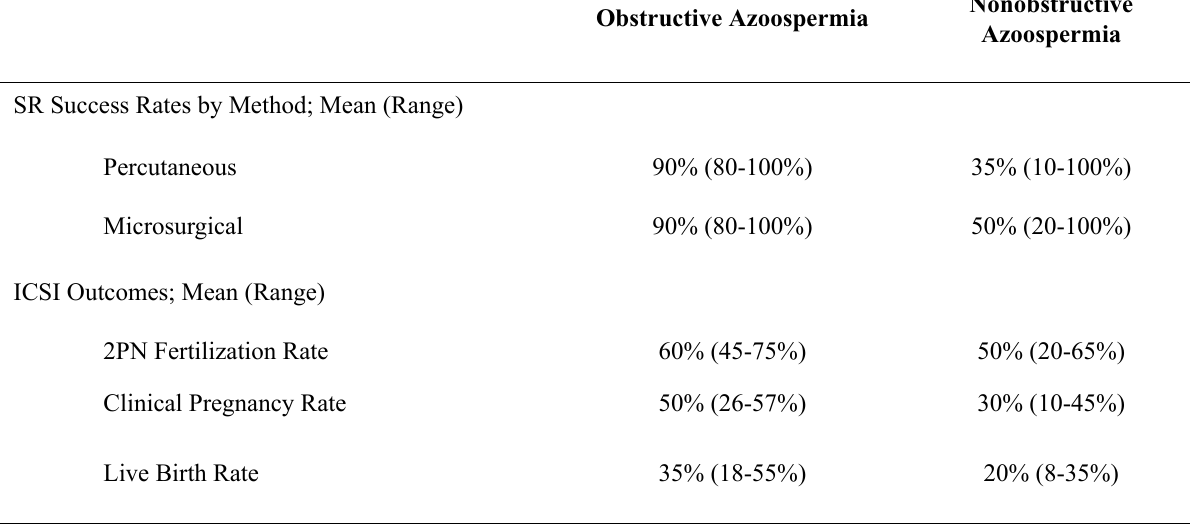
Table 3 - Sperm Retrieval (SR) Success Rates and Intracytoplasmic Sperm Injection Outcomes (ICSI) Using Surgically- Retrieved Spermatozoa from Men with Obstructive and Nonobstructive